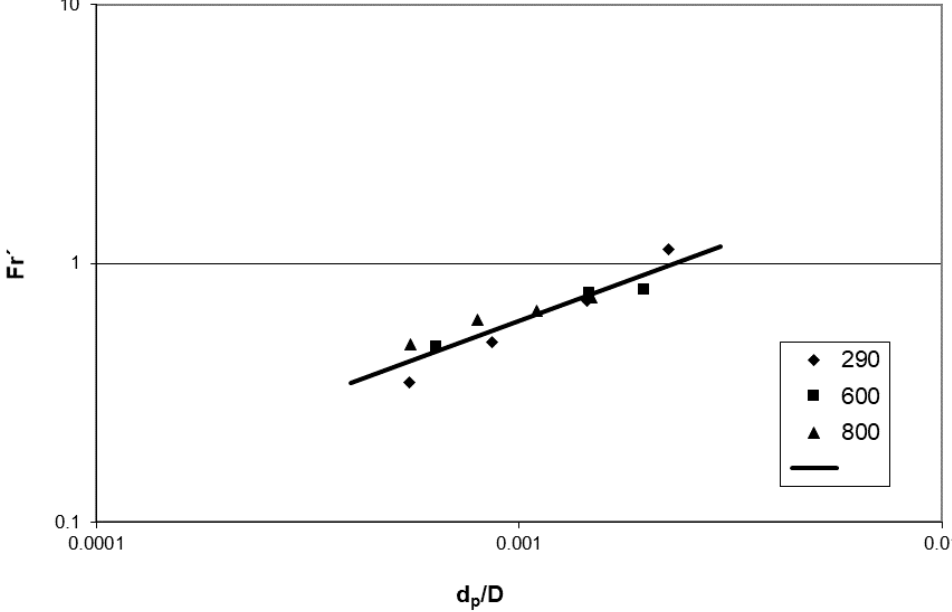
Figure 8. Dependence of Fr’ on relative particle size for pitched, four-blade turbines for mean volumetric concentration of particle (7.5%).